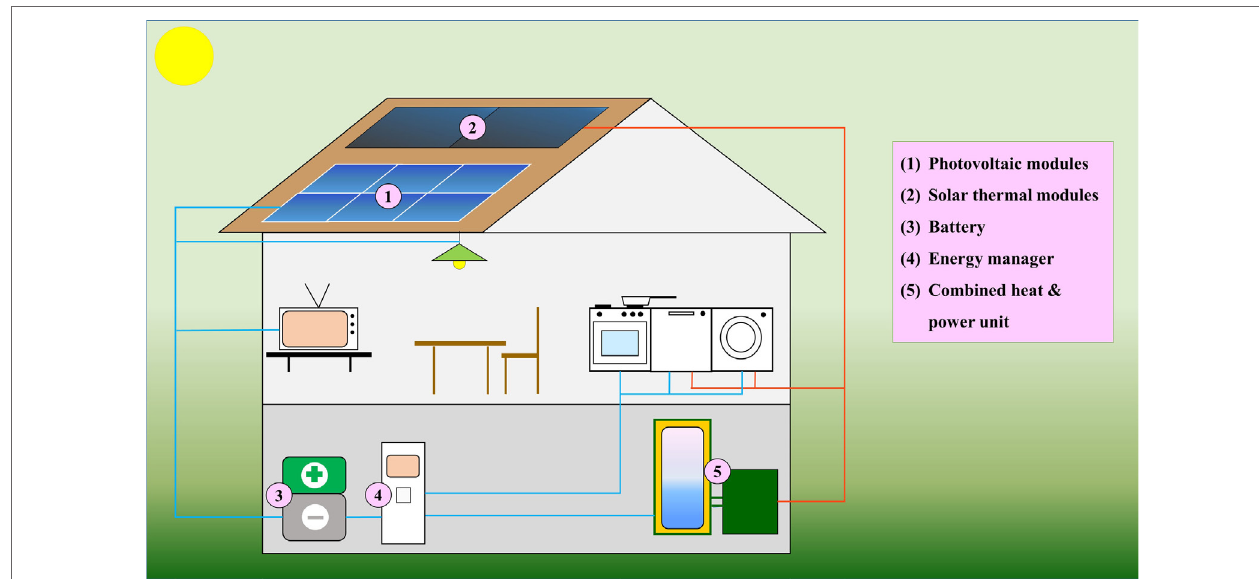
FigUre 2 | Household Scenario: energy autarky on the household